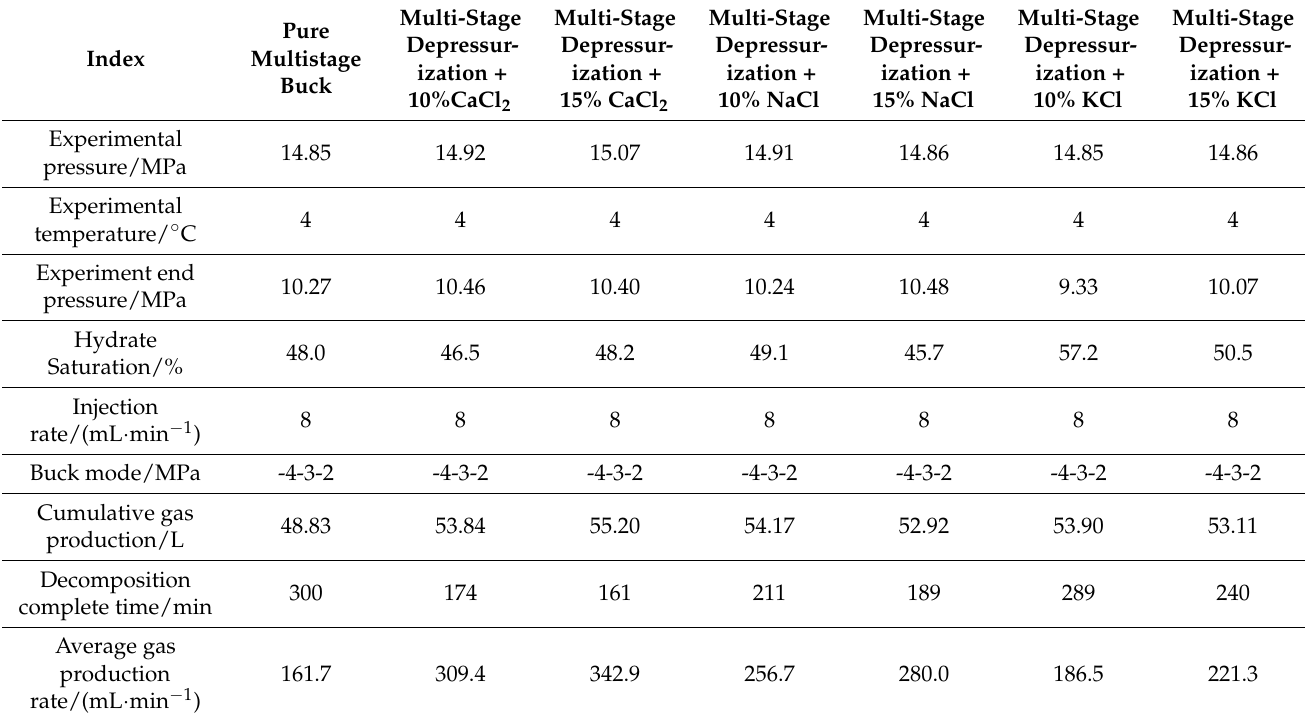
Table 2. Relevant experimental parameters of gas hydrate depressurization and salt injection